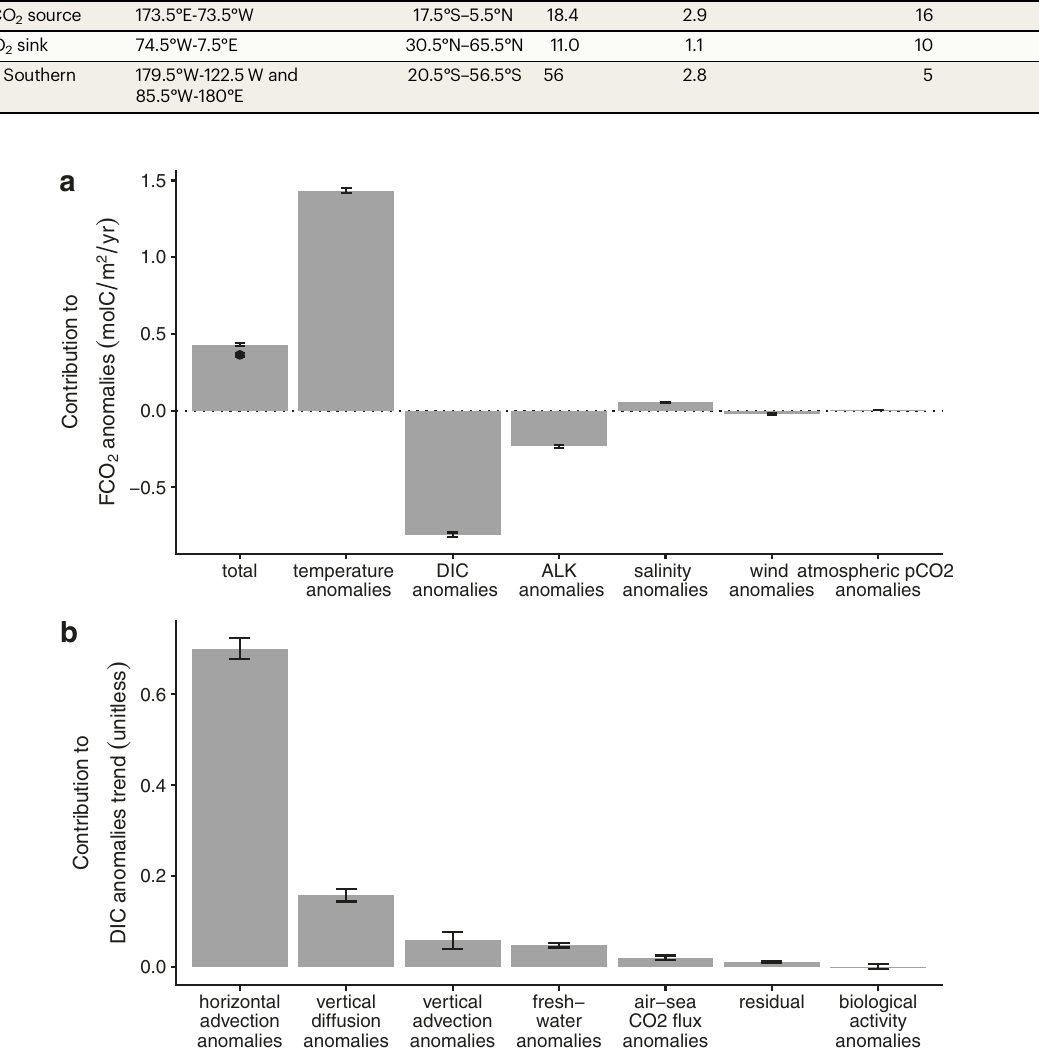
the Taylor decomposition. The error bars correspond to the 95% con fi dence interval. b Contributionofhorizontal,verticaldiffusion,verticaladvection,dilution andconcentrationduetofreshwater fl uxes,air-seaCO 2 fl uxdensity,aresidualterm and biological activity to the rate of change (tendency or trend) of DIC anomalies during PMHWs in the North Paci fi c CO 2 sink region for the 2009 – 2017 period (see methods section). The vertical bars represent the slope from linearly regressing each forcing term to the DIC anomalies trend 28 . A linearregression slope close to 1 indicates that a particular term produces in-phase anomalies of comparable mag- nitude. A slope near zero indicates that the term is not important in generating anomalies. The error bars correspond to 95% con fi dence